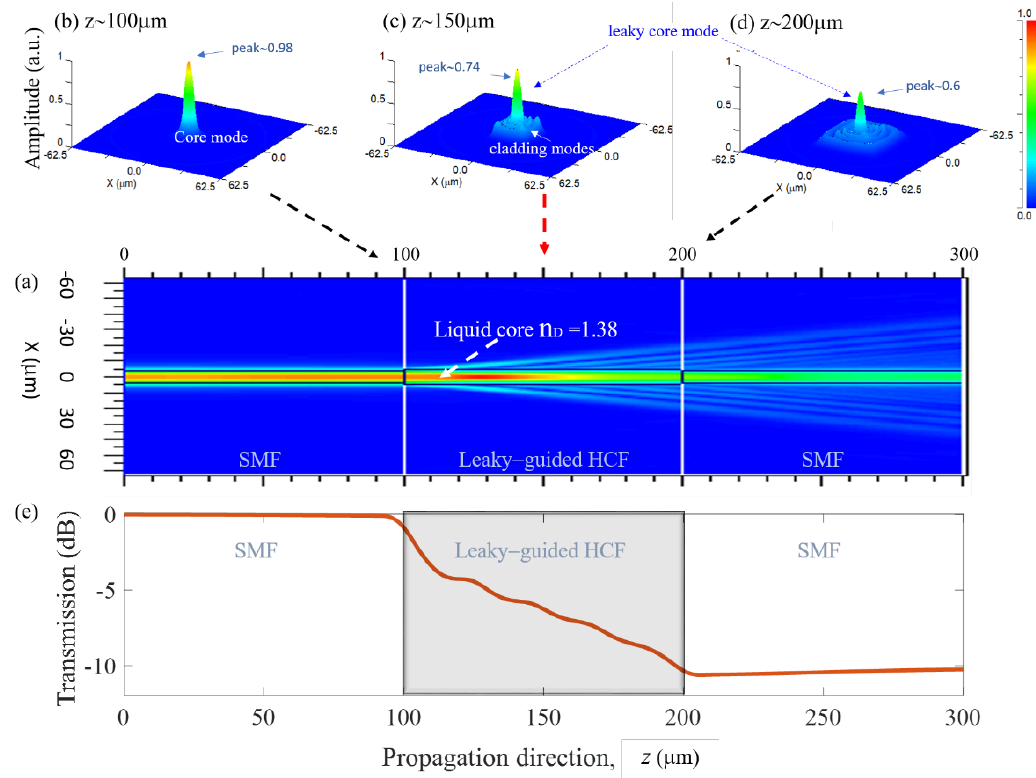
Figure 2. ( a ) FDBPM simulation of ( a ) optical light propagation and ( b – d ) evolution of the 3D optical power distribution inside the device configuration at ( b ) z = 100 µ m, ( c ) z = 150 µ m and ( d ) z = 200 µ m, respectively, and ( e ) optical transmission of the light propagation through the LLCFMZI.